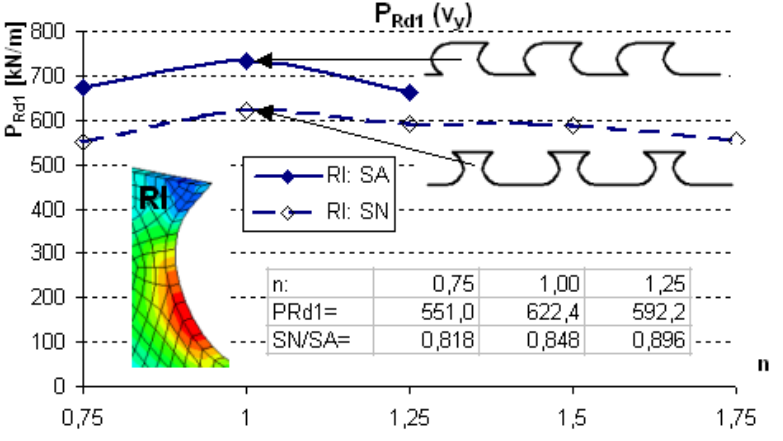
Figure 26: Results of shape optimization presenting the force per unit length versus shape ratio (1D1 model, linear concrete material and linear steel material; RI represents reduced integration in finite elements [1]).